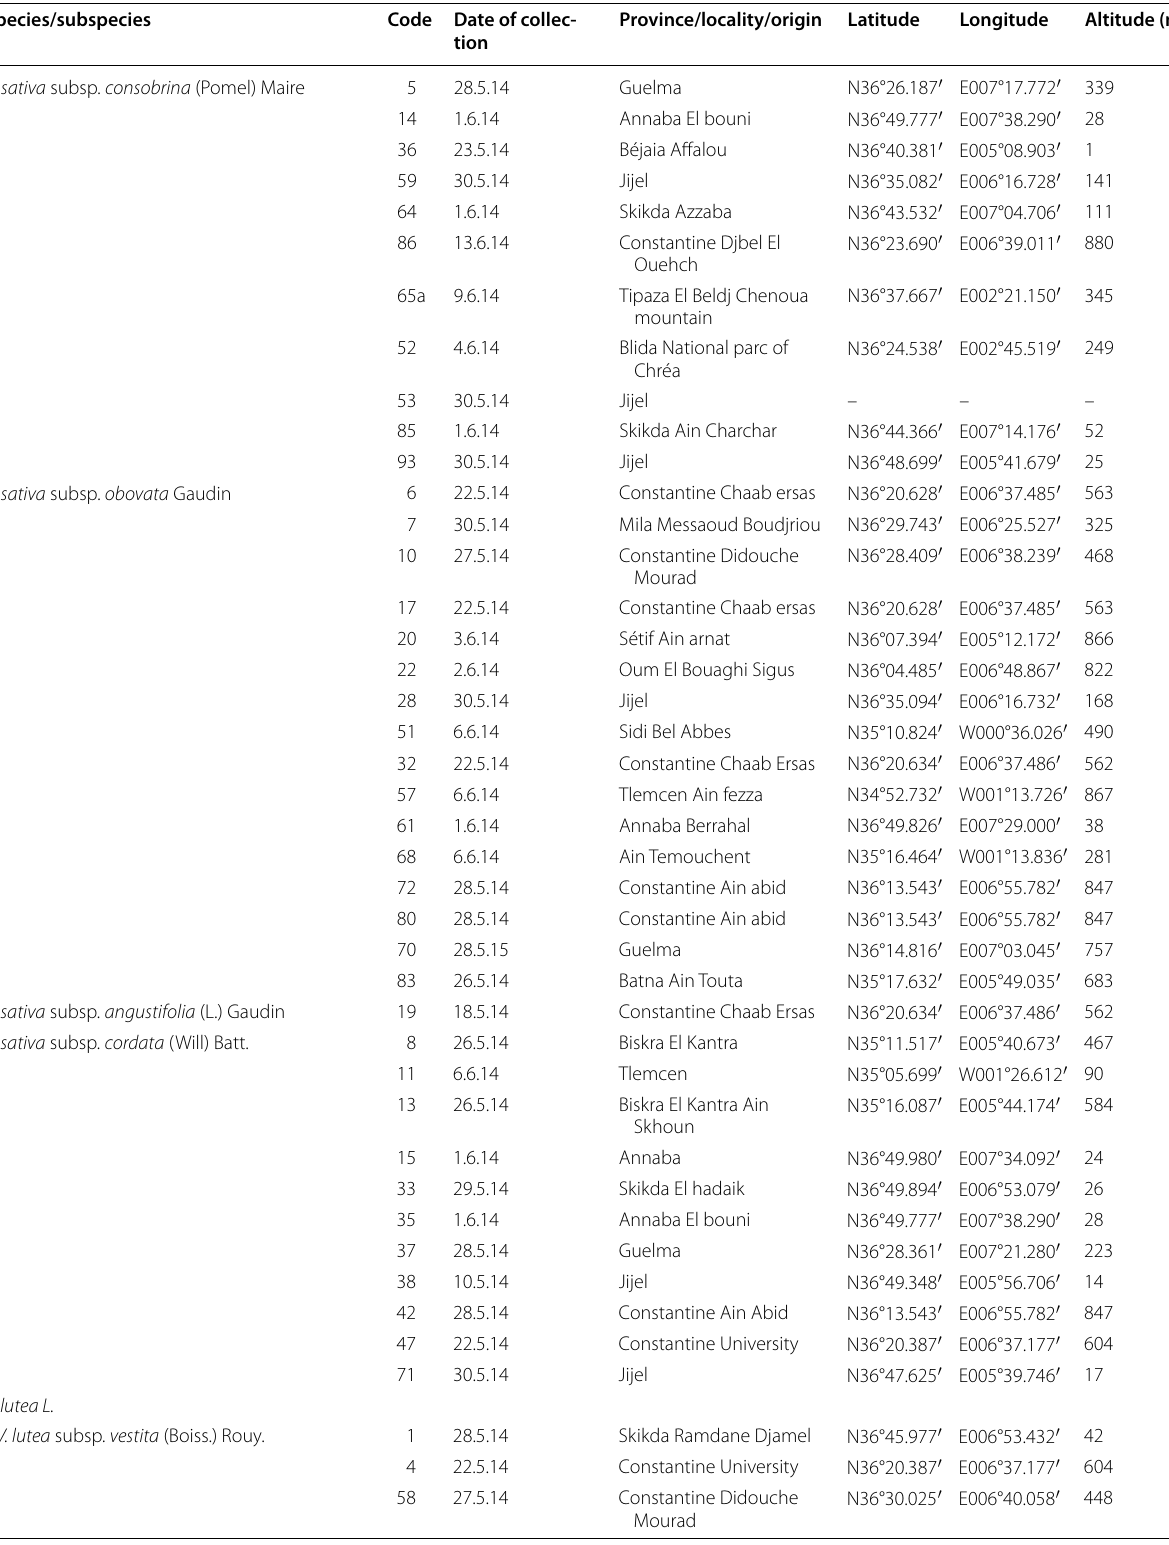
Table 1 Location and taxonomic identification of accessions